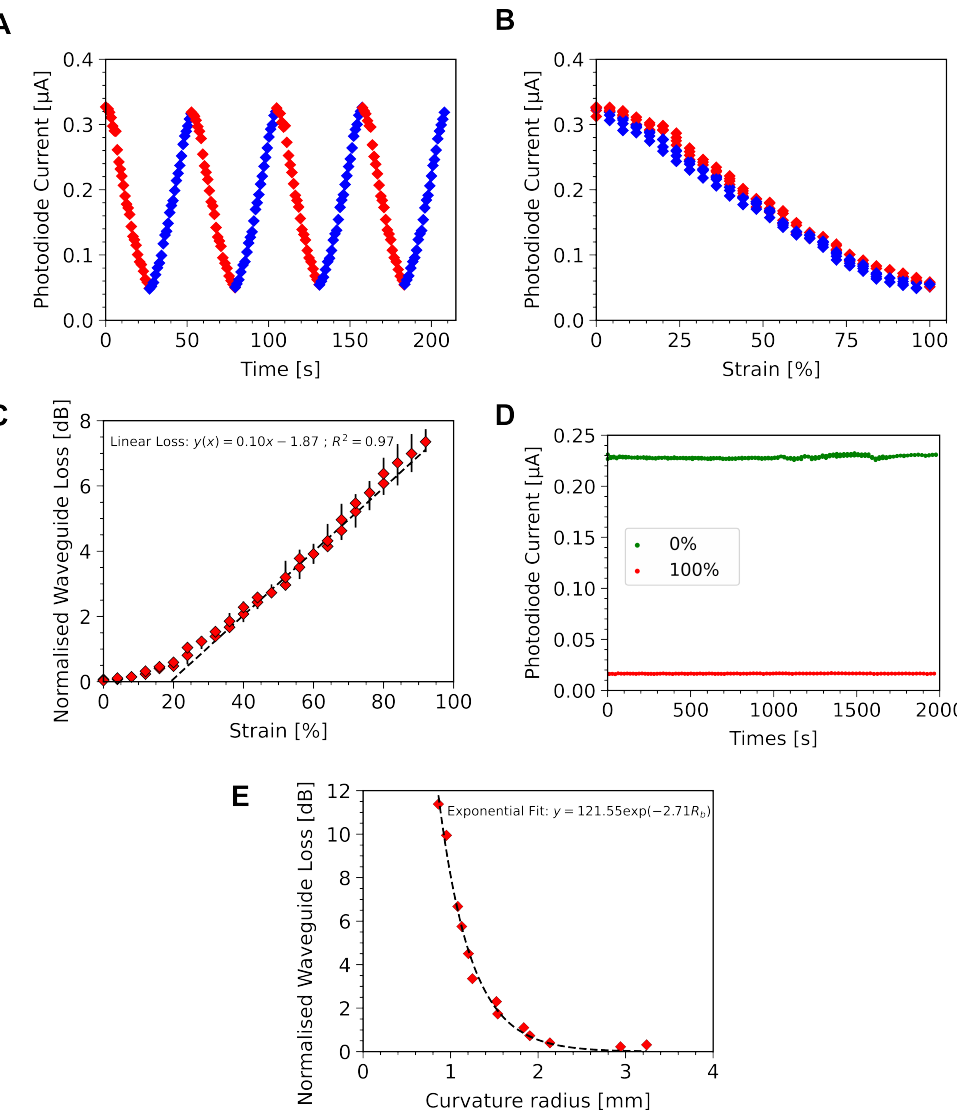
Figure 5. ( A ) Photo-current over time for four stretching cycles between 0% and 100% for a single device. ( B ) Photo-current against strain over four stretching cycles, stretching shown in red, relaxing in blue. Hysteresis is evaluated at around 10% for the same devices as ( A ), with an integrated current of 2.71 µ A % over a single strain cycle. ( C ) Calculated power loss in the waveguide with strain · averaged over 4 cycles for the same device a ( A ), showing a linear increase in loss with strains above 20%, represented by the fitted straight line, dashed black. Error bars show the spread of data over four loading and unloading cycles of a single device. ( D ) Measured photo-current from a new device over 100 cycles of stretching from 0% to 100%, current at 0% stretch in green and 100% stretch in red. ( E ) Calculated power loss in a 400 µ m thick waveguide with bending radius (red diamonds) and fitted exponential decay curve (dashed black line).